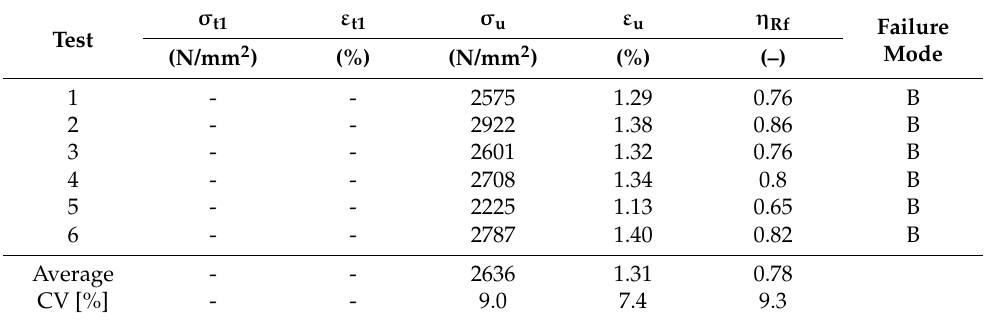
Figure 8. A-C test results: ( a ) stress–strain curves; ( b ) typical crack pattern; ( c ) specimens after the test. Table 8. A-C test results.